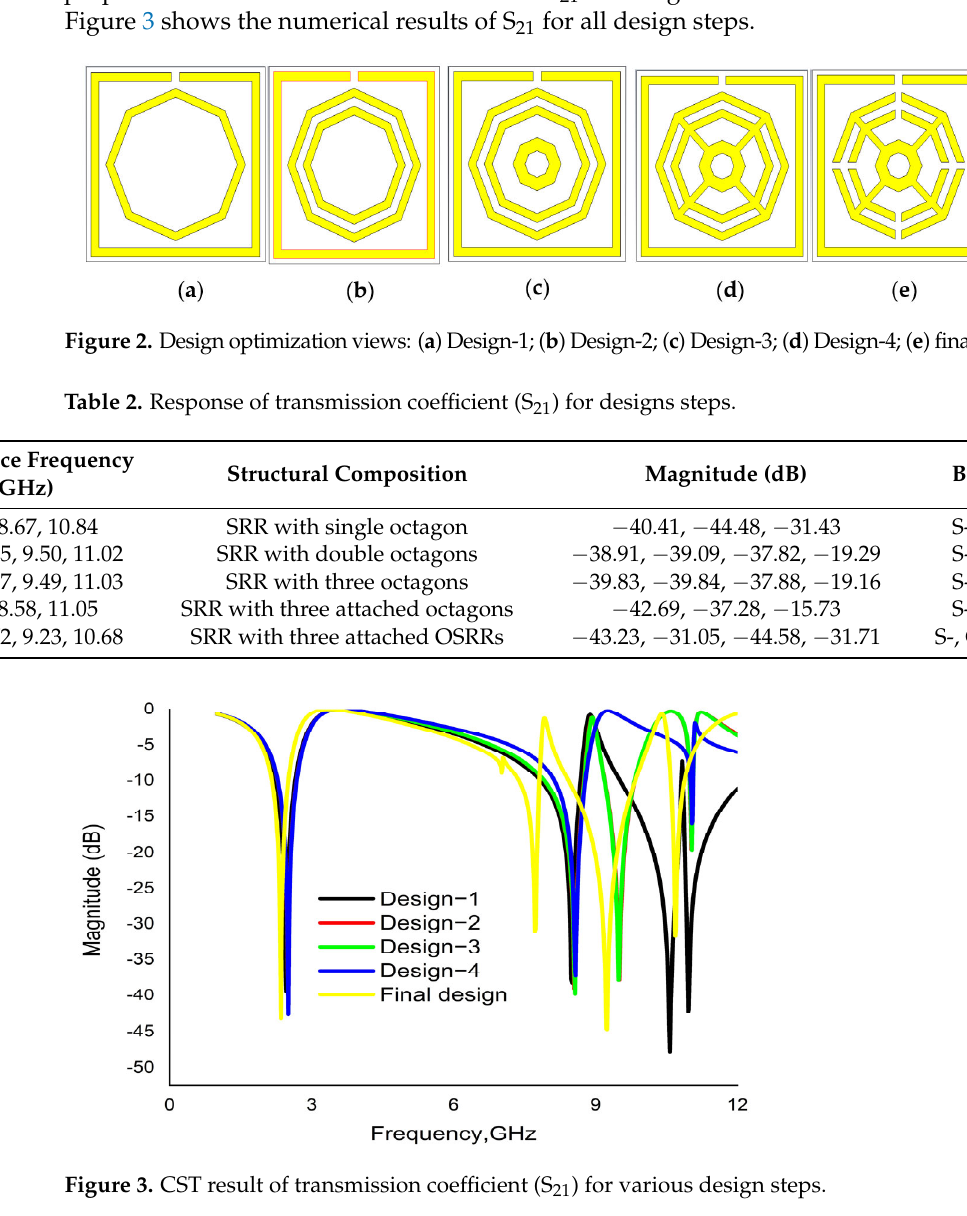
Table 2. Response of transmission coefficient (S 21 ) for designs steps .